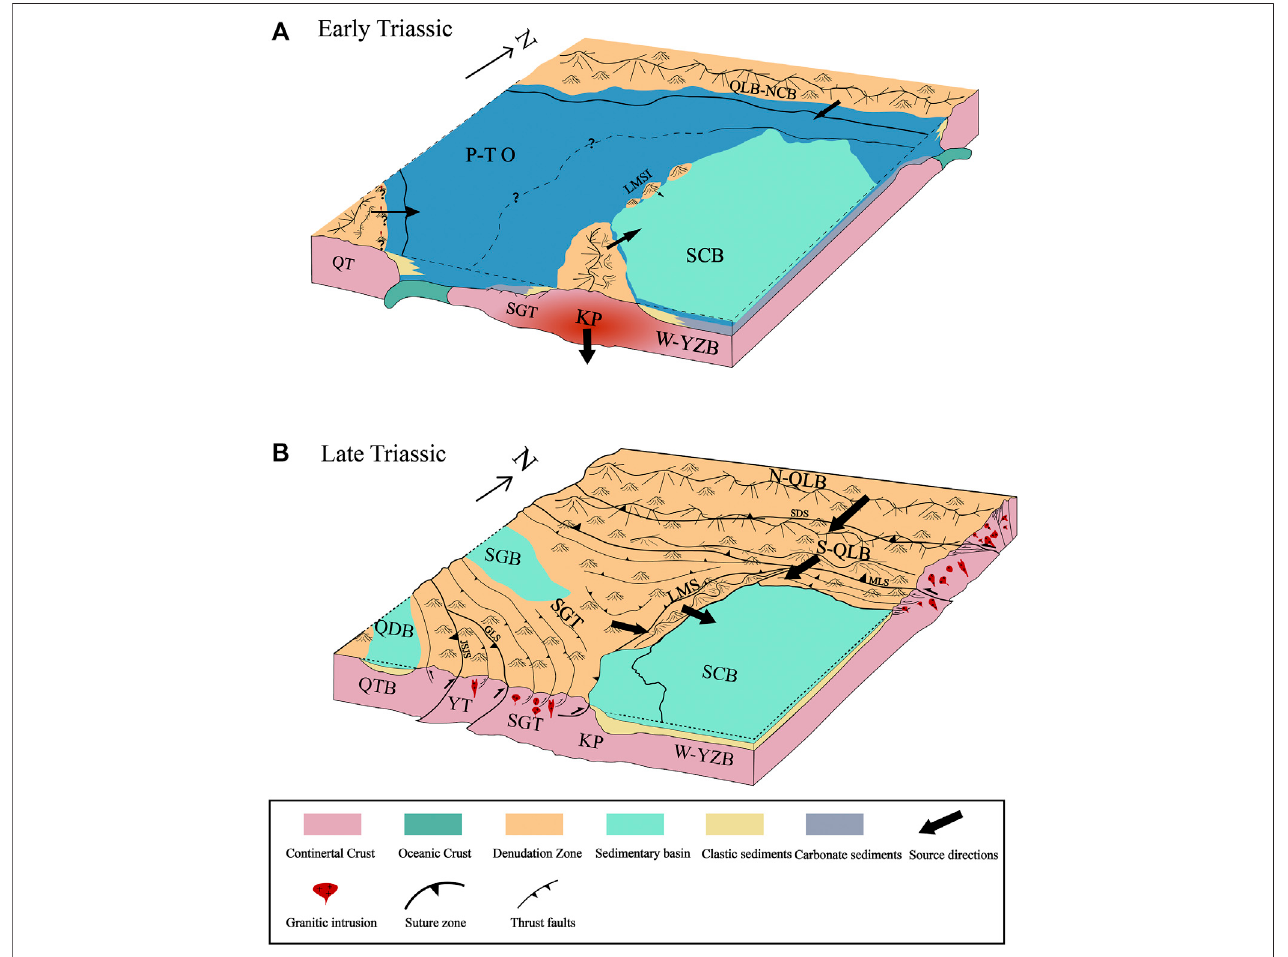
FIGURE 11 | Schematic diagram showing the Early Triassic (A) and Late Triassic (B) tectonic evolution of the Northwestern Sichuan Basin (modi fi ed from Yan (2018)). SCB, Sichuan Basin; SGT, Songpan-Ganzi terrane; QLB-NCB, Qinling belt-North China Block; S-QLB, South Qinling belt; N-QLB, North Qinling belt; LMS, Longmenshan thrust belt; LMSI, Longmenshan island; P-T O, Paleo-Tethys Ocean; QTB, Qiangtang Block; YT, Yidun terrane; KP, Khamdian Paleoland; W-YZB, Western Yangtze Block; SDS, Shangdan suture; MLS, Mianlue suture; GLS, Ganzi – Litang suture; JSJS, Jinshajiang suture.